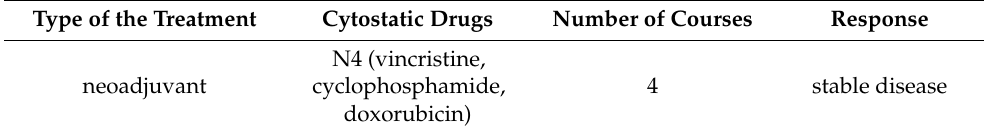
Table 4. Chemotherapy in patient